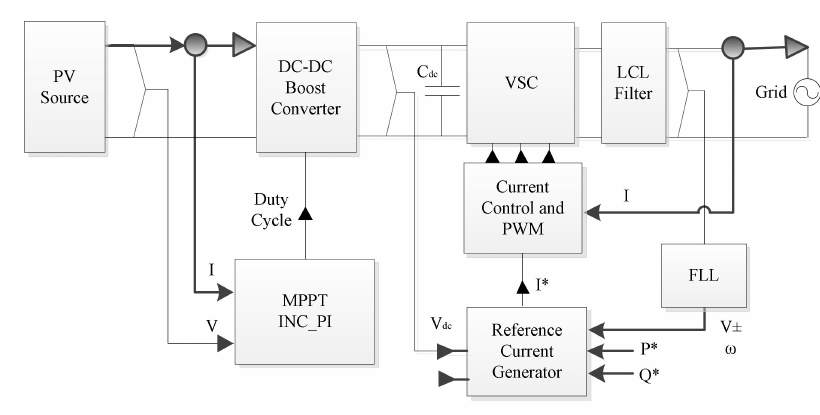
Figure 1. Block diagram of the grid-connected photovoltaic (PV)